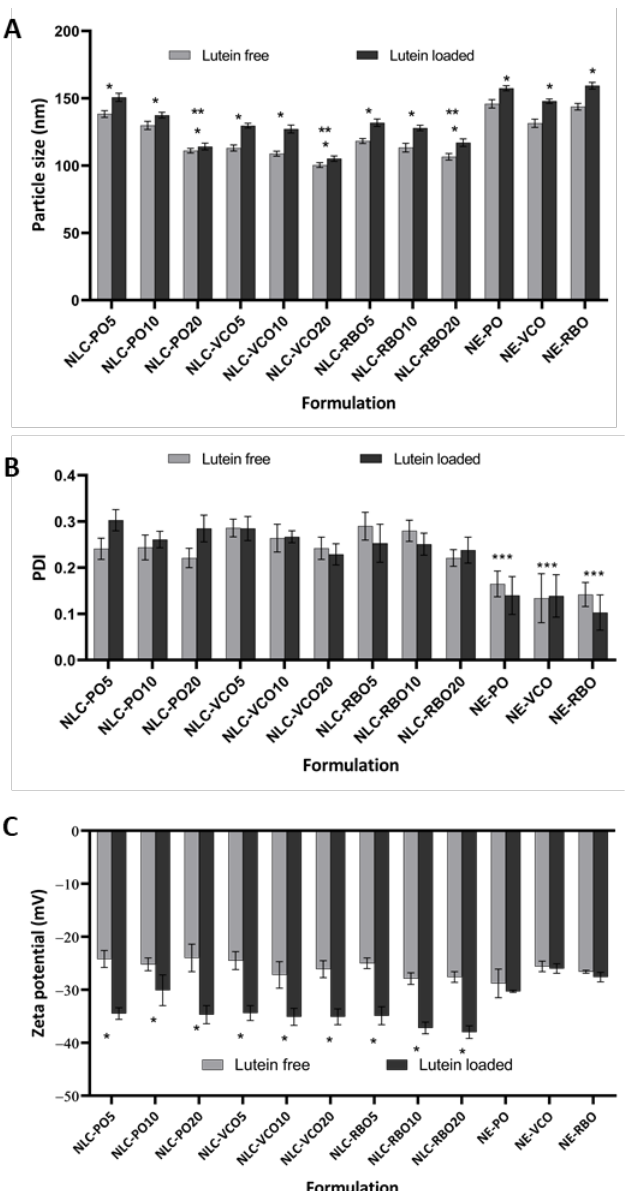
Figure 1. Particle size ( A ), PDI ( B ) and ZP ( C ) of lutein-free and lutein-loaded lipid nanocarriers after production. * Statistically significant difference comparing lutein-free and lutein-loaded nanocarriers ( p < 0.05), ** statistically significant difference comparing all L-NLC formulations that contain the same type of oil ( p < 0.05); *** statistically significant difference comparing all lutein-loaded nanocarriers ( p < 0.05).